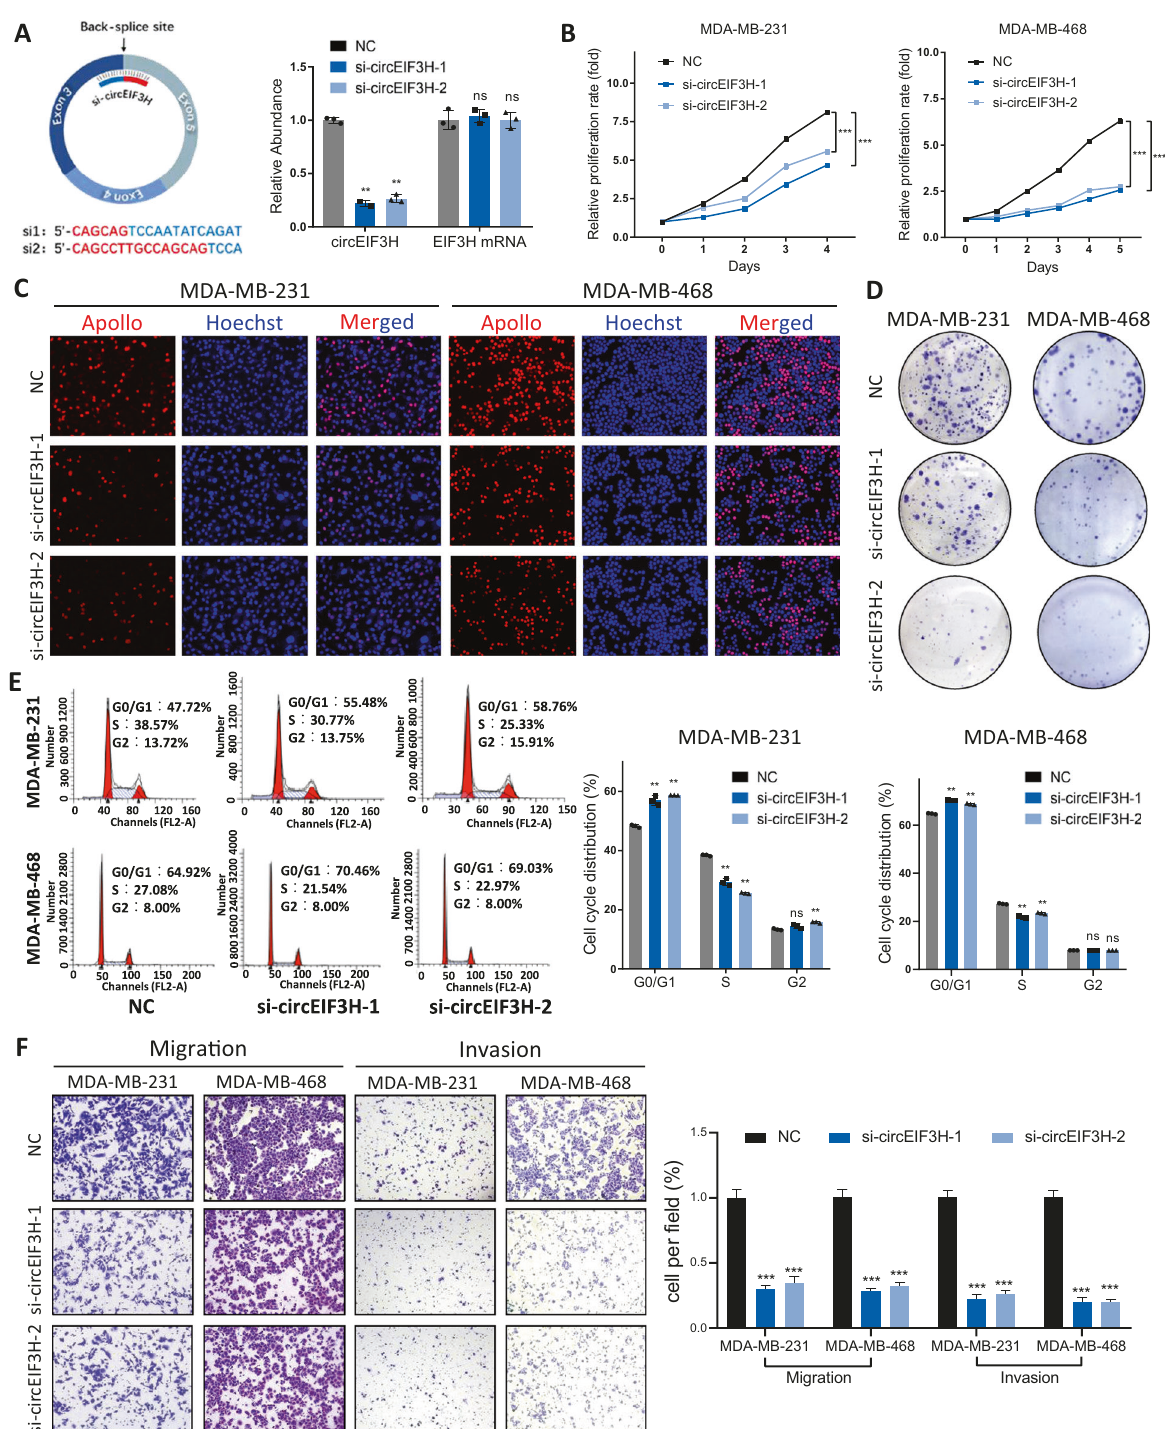
Fig. 2 CircEIF3H was essential for TNBC progression. A Schematic illustration of siRNAs speci fi c to the back-splicing junction of circEIF3H and the interfering ef fi cacies measured by qRT-PCR. B – D The effects of circEIF3H knockdown on the proliferation of MDA-MB-231 and MDA- MB-468 cells were examined by MTT ( B ), EdU ( C ), and colony formation assays ( D ). E Cell cycle distributions in circEIF3H knockdown cells were presented by fl ow cytometry. F Transwell migration and invasion assays were used to evaluate the motility of MDA-MB-231 and MDA-MB-468 cells transfected with si-NC or si-circEIF3H. The quantitative data were presented as mean ± S.D. Statistical signi fi cance was determined by two-sided Student ’ s t -test, ** P < 0.01, and *** P < 0.001. Cell experiments were repeated three times. result (Fig. S5A). RIP assay was performed to verify the interaction of circEIF3H was positively correlated to them (Fig. 4C, D). This between IGF2BP2/HuR and HSPD1/RBM8A/G3BP1, and the results positive correlation between circEIF3H and HSPD1/RBM8A/G3BP1 showed that HSPD1/RBM8A/G3BP1 were signi fi cantly enriched in was also detected in 3 different TNBC cell lines (MDA-MB-231, both IGF2BP2 (Fig. 4E) and HuR (Fig. 4F) precipitates. To further MDA-MB-468, and MDA-MB-453), which further con fi rmed our Cell Death Discovery (2022)